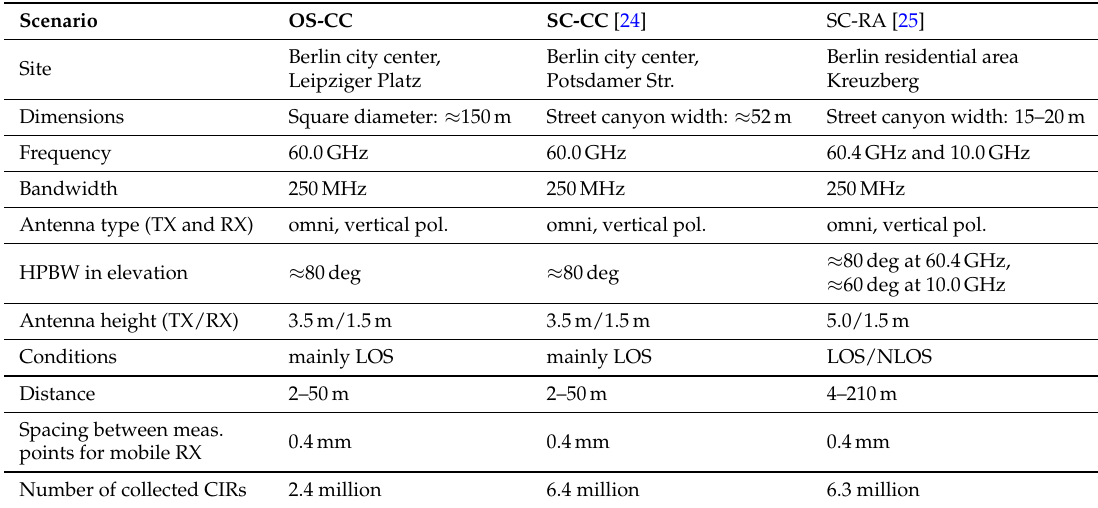
Table 1. Summary of measured urban microcellular (UMi) scenarios and main parameters.